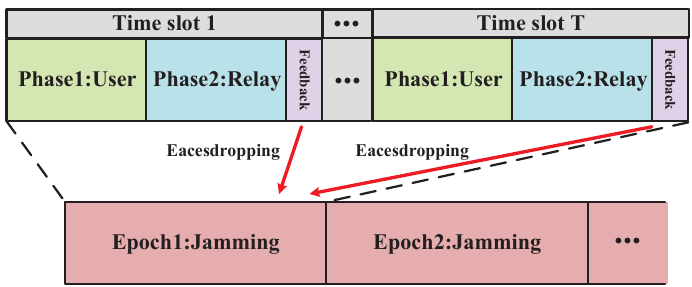
Figure 2. Anti-jamming communication time slot division.